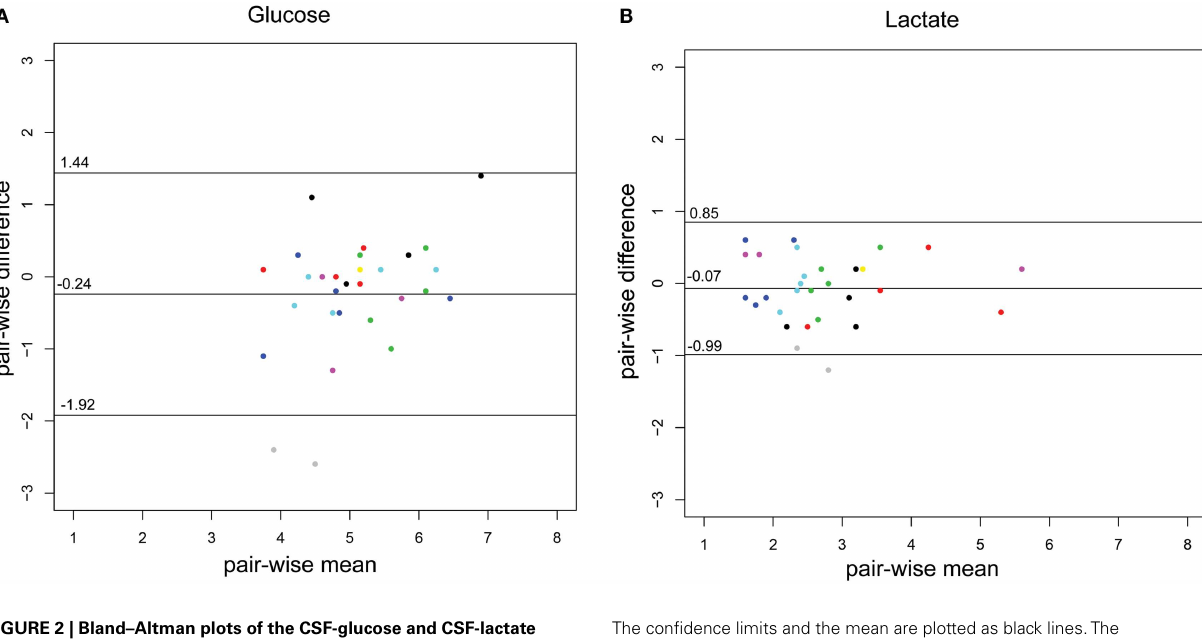
The confidence limits and the mean are plotted as black lines.The variance for glucose and lactate are 0.51 and 0.13, respectively. Every patient ( n = 14) is represented by a unique color.Two points lay outside the confidence limits in (A) (glucose) while one point is outside the confidence limits in (B) (lactate).